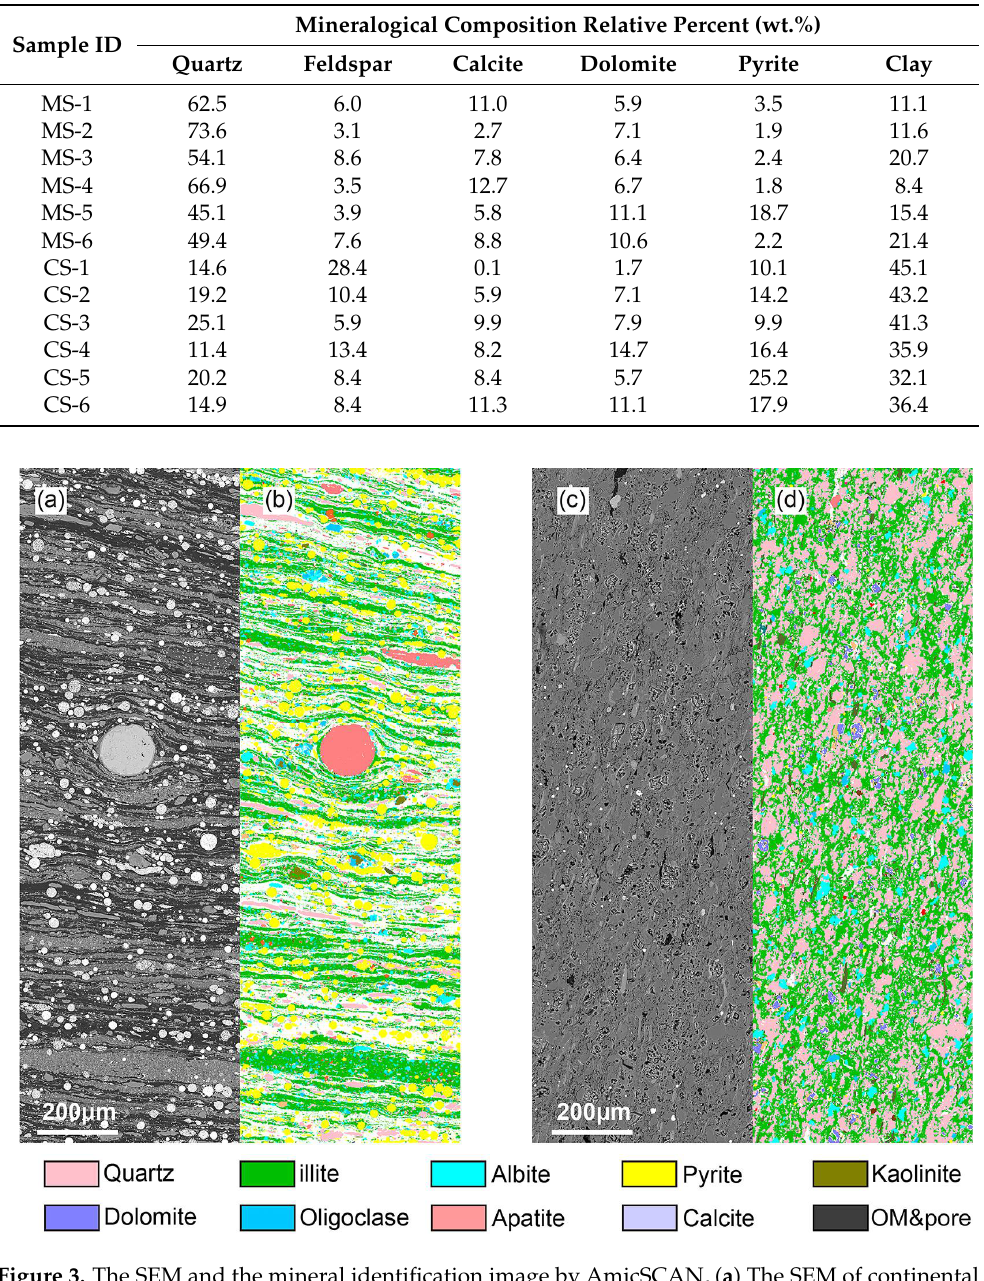
Table 2. Mineral composition of marine shale (MS) and continental shale (CS).